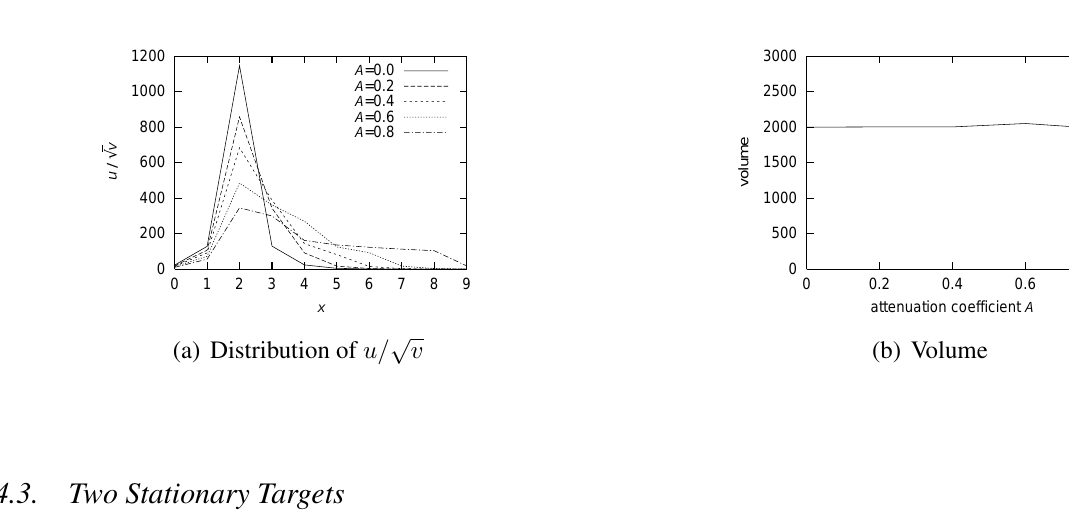
Figure 10 . Simulation results of one moving